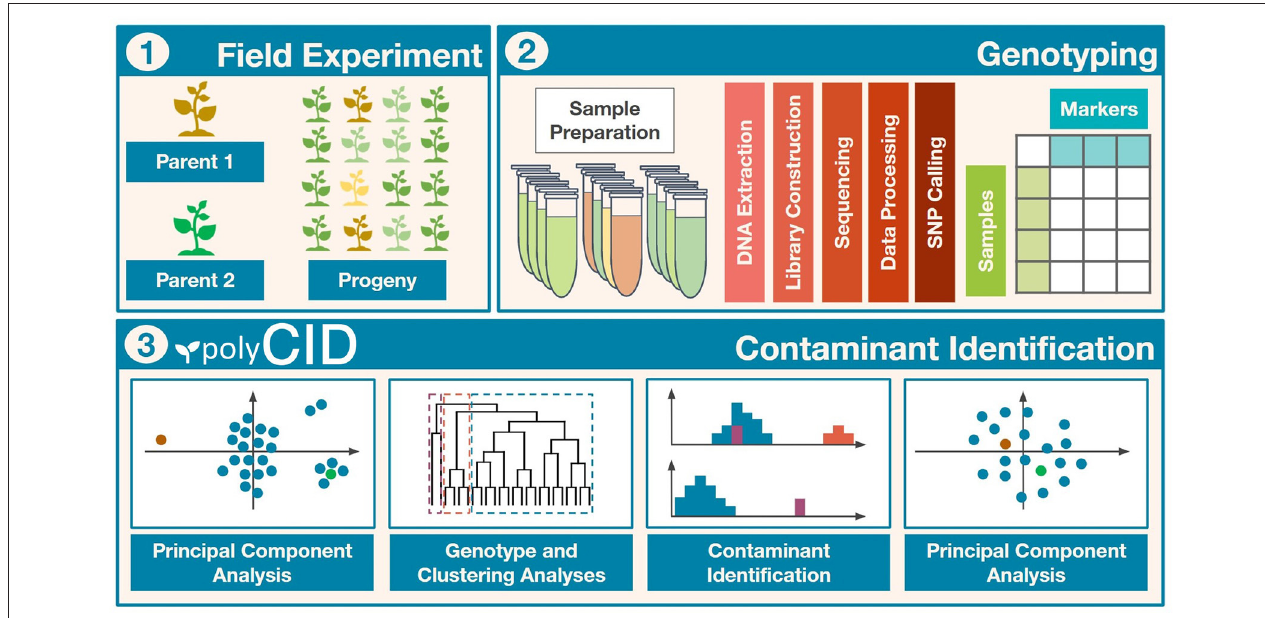
FIGURE 1 | Workflow of the contaminant identification process. (I) Field experiment to obtain the biparental progeny. (II) Population genotyping and bioinformatic analyses. (III) Methodology with principal component analysis (PCA), genotype analysis (GA), and clustering analysis (CA) to identify and remove contaminants.